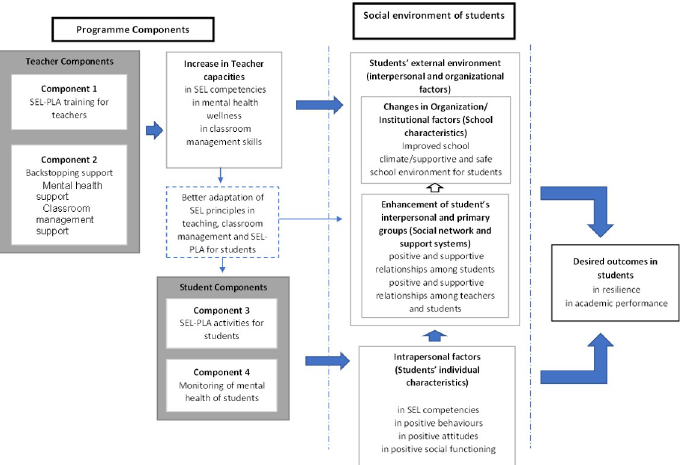
Fig 2. Conceptual framework of the